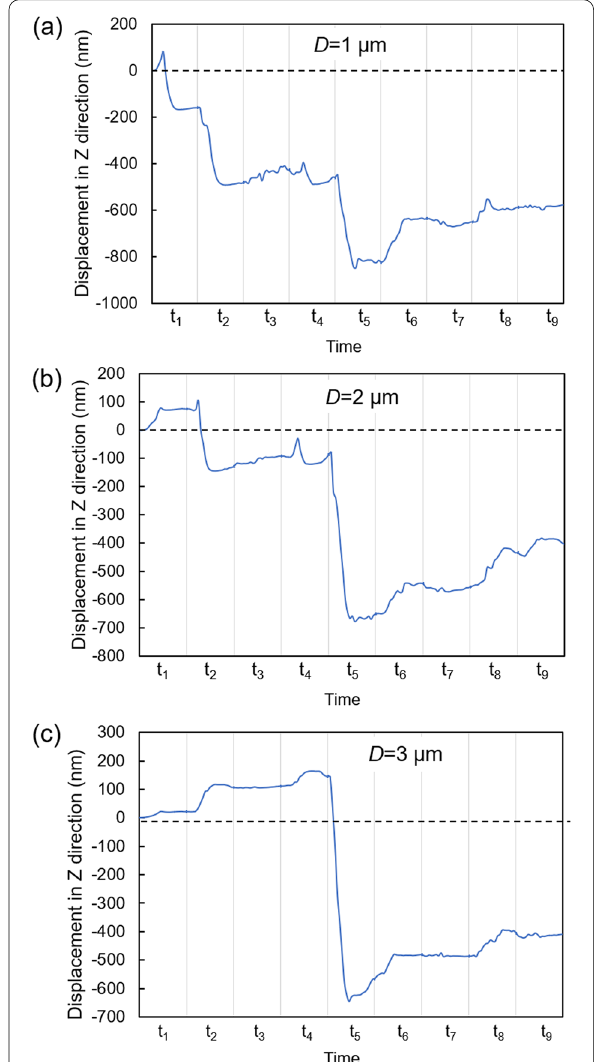
Figure 16 Change of the deformation for the fifth indentation center point of the 3 3 indentation arrays obtained by the rotation × angle of 0° in Z direction with the time for the spacings of a 1 μm, b 2 μm and c 3 μm